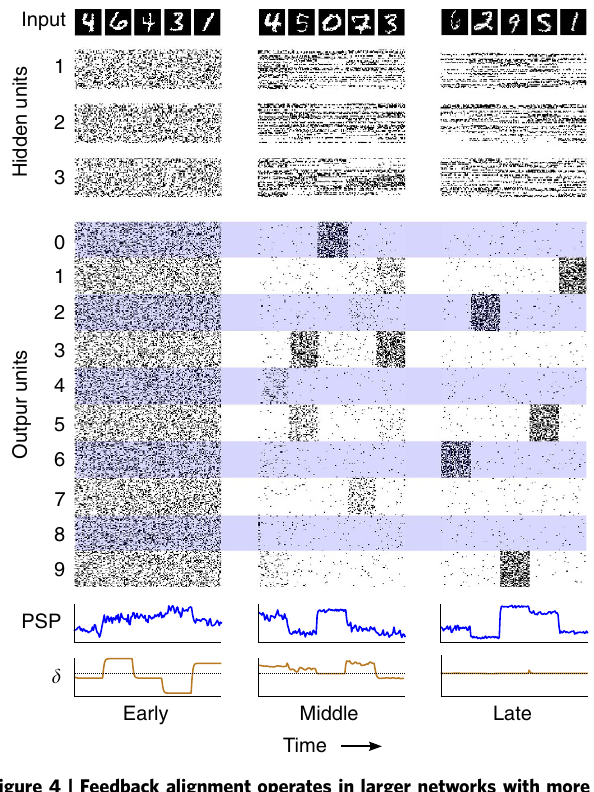
Figure 4 | Feedback alignment operates in larger networks with more complex dynamics. A network (784-1500-1500-1500-1000) of neurons that integrate their activity over time and spike stochastically, learns to recognize handwritten digits. The inputs (images along top) were presented to the network for 50 time steps each. Rasters show spikes of 50 randomly selected units from each of the three hidden layers (1, 2 and 3) and of the 1,000 output units (100 for each of the 10 classes, ‘0’ through ‘9’). The plots at the bottom show that a single forward neuron’s PSP and its modulatory signal d j (a.u.), evolve continuously and simultaneously. All variables are shown at three stages of learning: early; middle; and late.